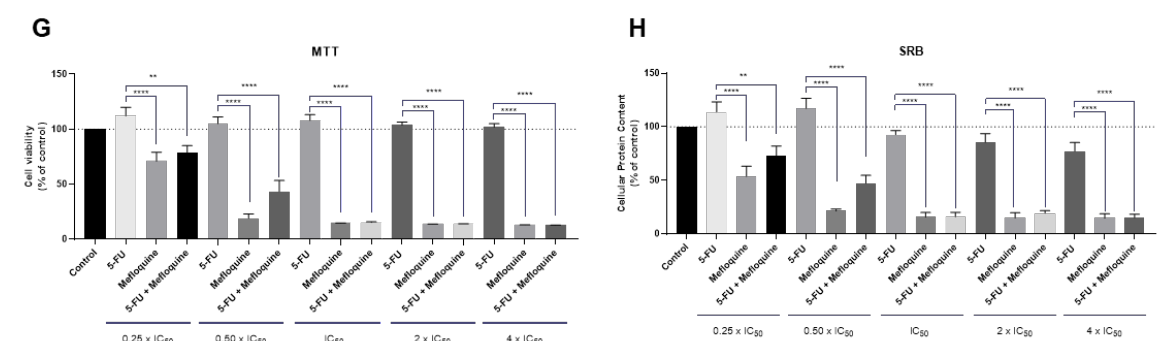
Figure 4. Growth inhibition of HT-29 after 48 h of combination therapy, by MTT (left) and SRB assays (right). Cells were exposed to concentrations of each drug of 0.25, 0.5, 1, 2 and 4 times their IC 50 and the cell viability was evaluated by MTT and SRB assays. The drugs in combination were co-administered at the same time. ( A ) The effect of 5-FU plus latrepirdine on cell viability and ( B ) cell protein synthesis. ( C ) The effect of 5-FU plus thioridazine on cell viability and ( D ) cell protein synthesis. ( E ) The effect of 5-FU plus sertraline on cell viability and ( F ) cell protein synthesis. ( G ) The effect of 5-FU plus mefloquine on cell viability and ( H ) cell protein synthesis. Values are expressed in percentage of control and represent means ± SEM. Each experiment was done three times independently ( n = 3); * statistically significant vs. control at p < 0.05. ** statistically significant vs. control at p < 0.01. *** statistically significant vs. control at p < 0.001. **** statistically significant vs. control at p < 0.0001. B